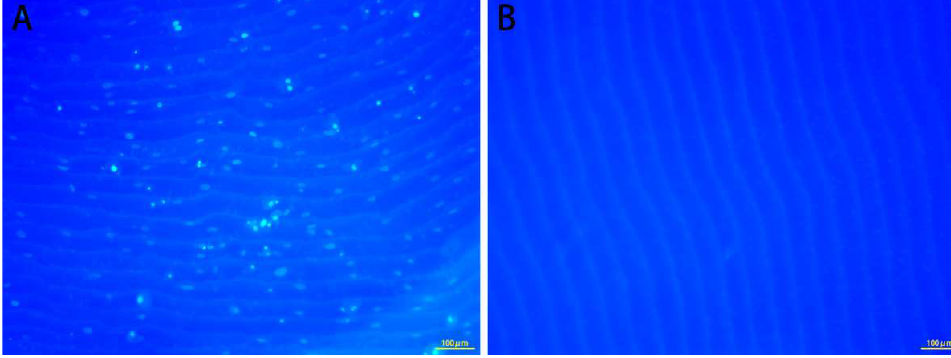
Figure 1. DAPI staining of FS with cells ( A ) and decellularized FS ( B ). FS is oval and transparent, about 25 mm in diameter with the basic shape of fish scale (Figure 2C). SEM analysis indicates that there were “petal-like” radial ridges and no pores on the surface of FS. The upper surface of FS (Figure 2D) is irregular with curved ridges. On the lower surface (Figure 2F), parallel circular ridges and longitudinal grooves are seen. The lateral surface of FS (Figure 2E) is more uniform with parallel circular ridges forming concentric arcs with the scale focus in the center. FS is a multi-layer structure with type I collagen fibers arranged in parallel and some spherical or cubic crystals embedded between each layer of collagen fibers, as shown in the longitudinal section (Figures 1A and